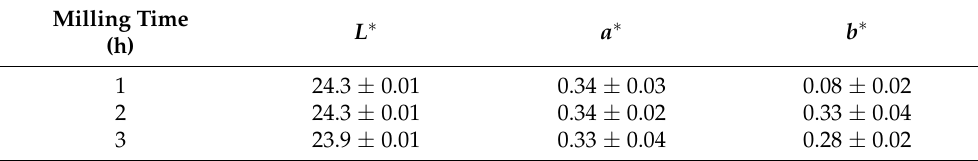
Table 6. Colorimetric results of the CB dispersion prepared with SMA-2000. Milling Time